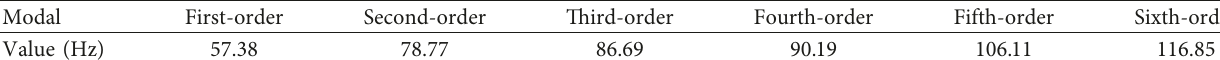
Figure 22: Modal analysis of the first six orders of the front-end framework. (a) First-order modal finite element analysis results; (b) second- order modal finite element analysis results; (c) the third-order modal finite element analysis results; (d) fourth-order modal finite element analysis results; (e) fifth-order modal finite element analysis results; and (f) sixth-order modal finite element analysis results. Table 6: Modal values of each order.